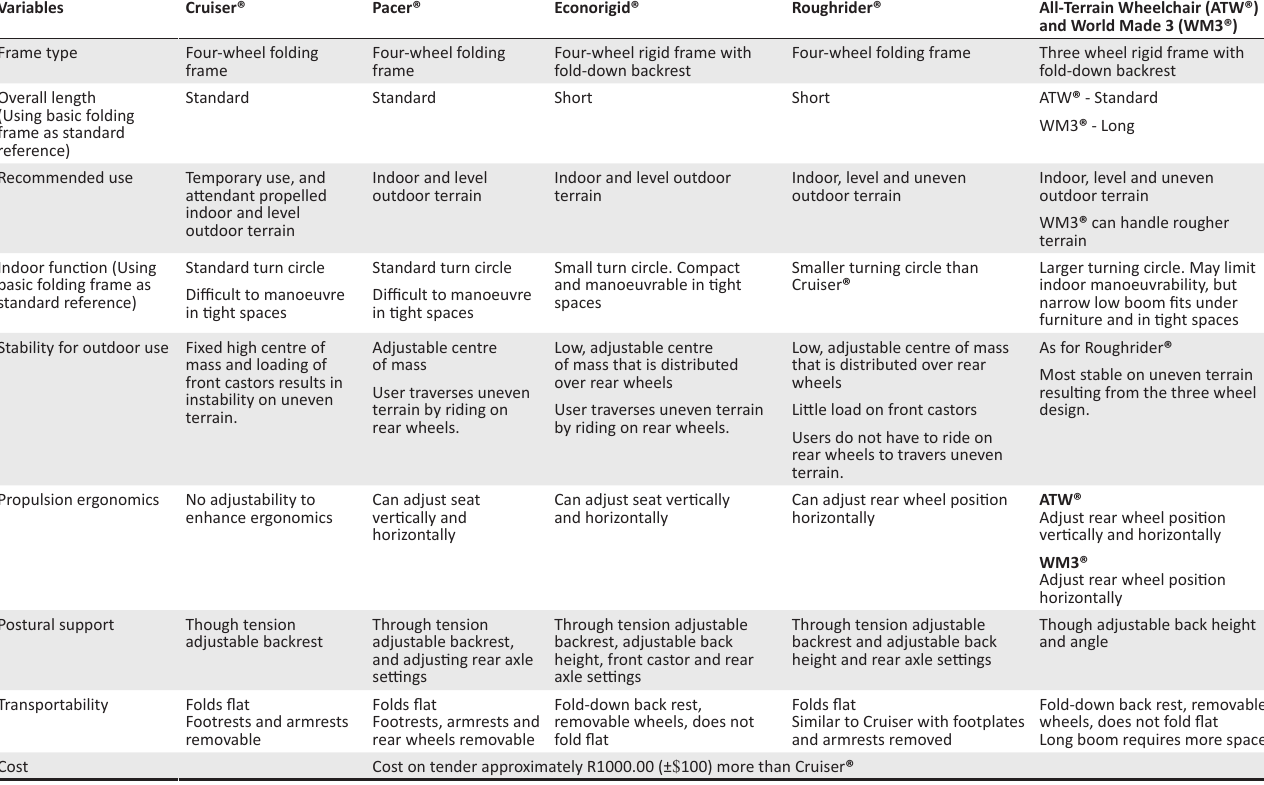
TABLE 1: Features of the different categories of wheelchair available on national tender. Variables